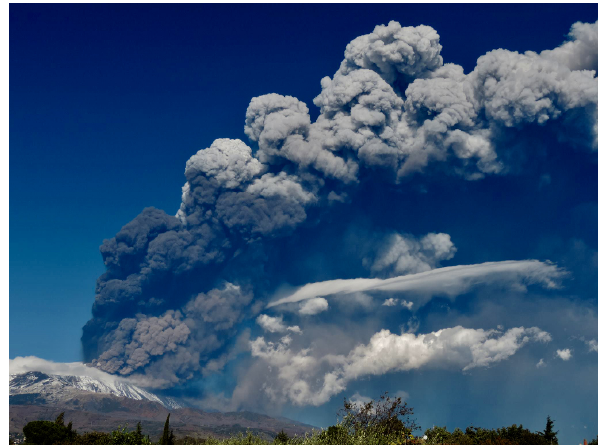
Figure 2. Photograph of the eruption showing the formation of the two volcanic clouds rising at different altitudes (greyish above the brownish). Source: courtesy of Boris Behncke